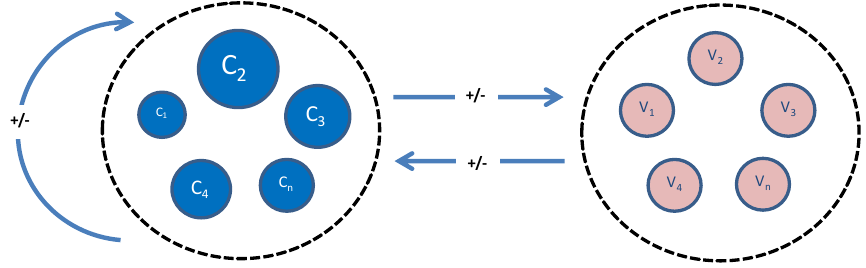
Figure 2. Schematic diagram of the proposed interactions between elements in the network structure of the decision model of the choice of a form of use alternative in the adaptation of a historic building.